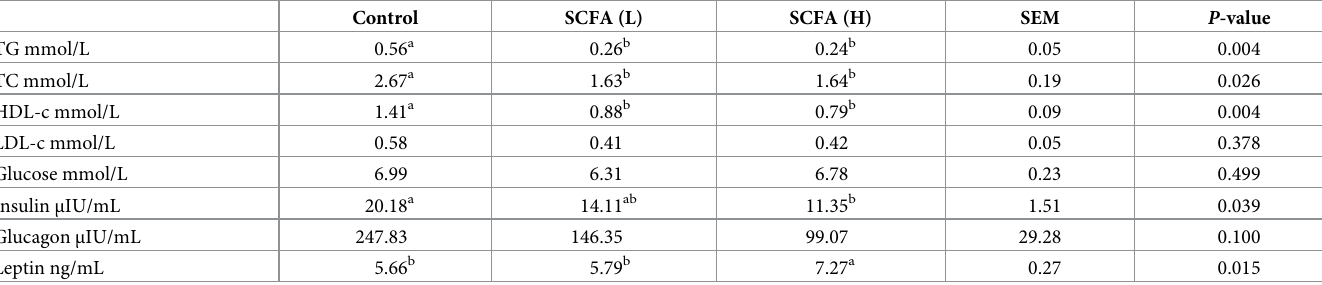
Table 4. Effects of SCFAs on the serum metabolites over the experimental period of weaned